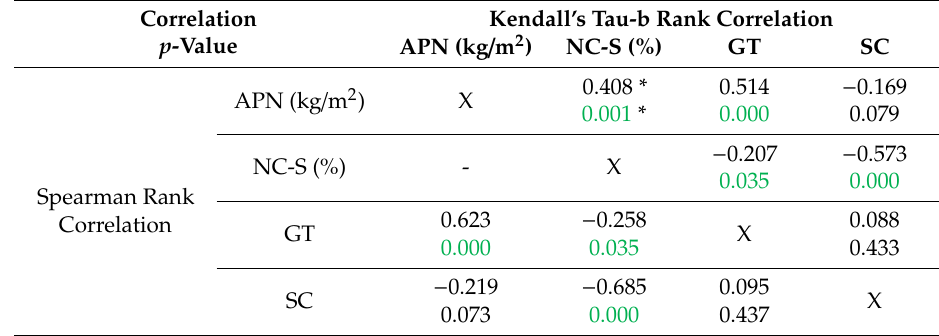
Table 3. Spearman and Kendall Tau-b rank correlation coe ffi cients between pairs of variables (ordinal–continuous and